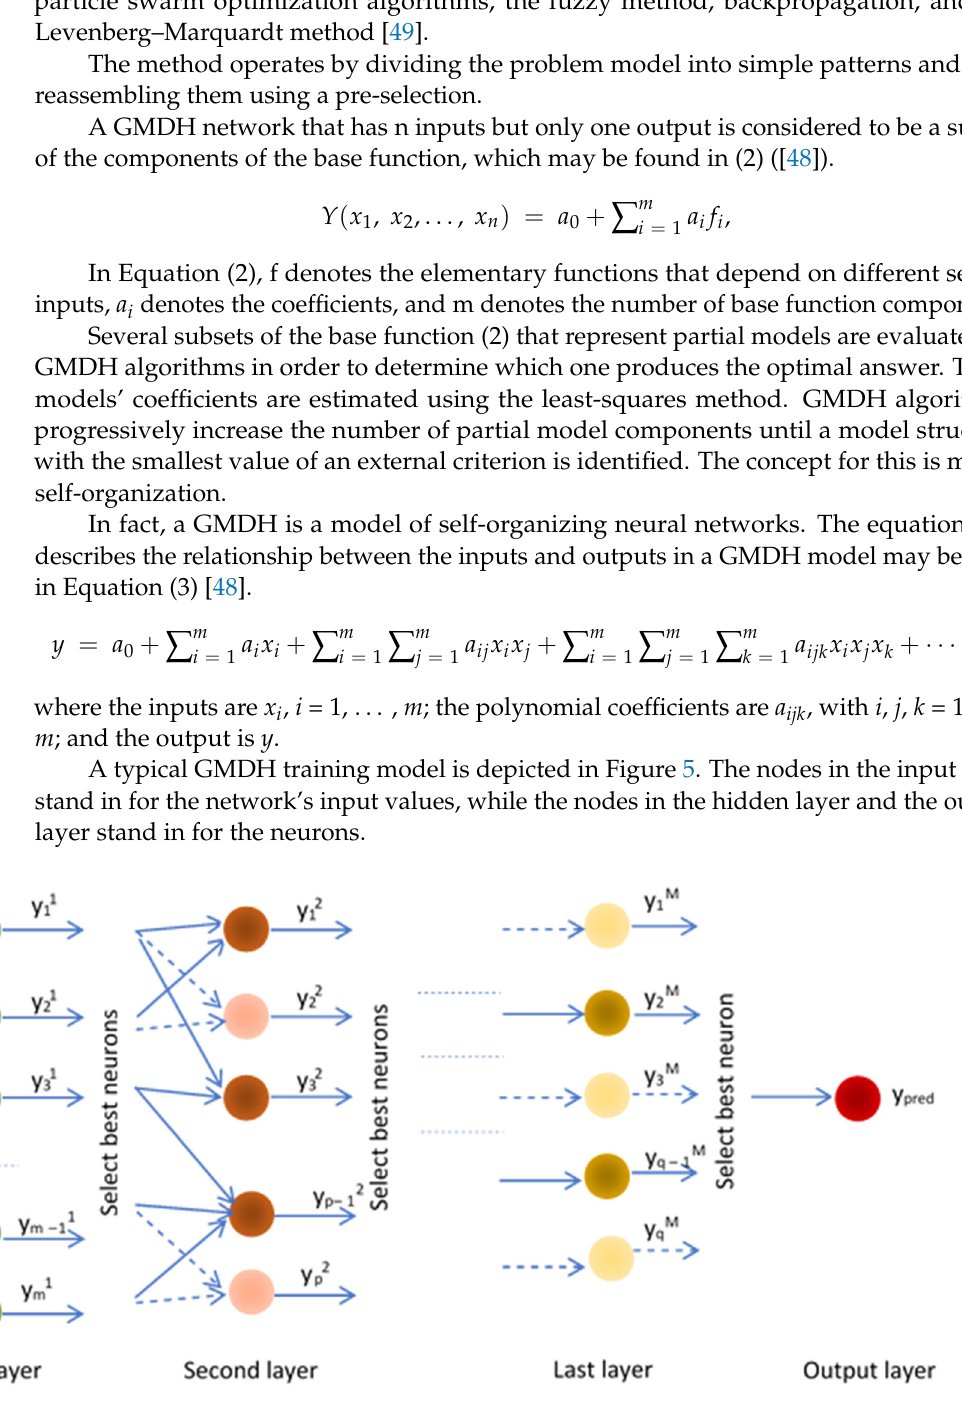
Figure 5. The typical structure of a GMDH neural network.